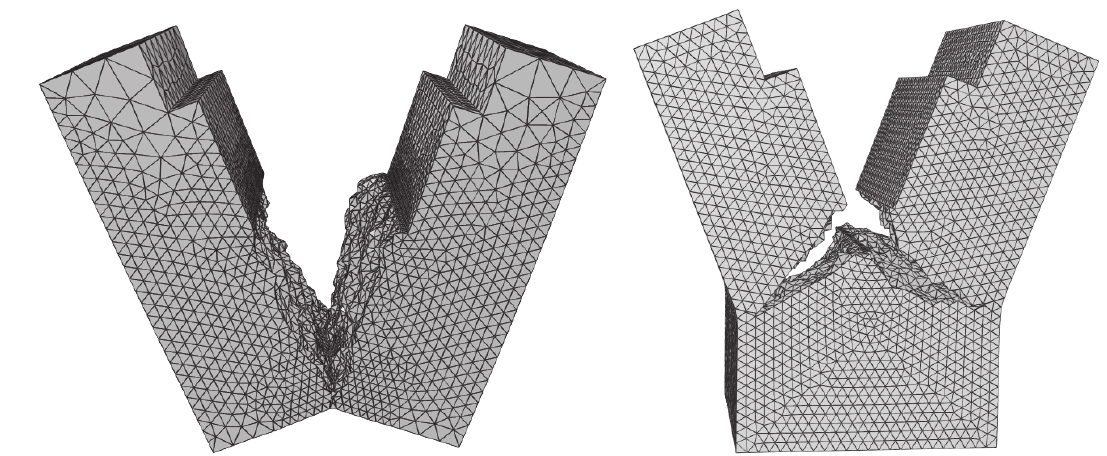
Figure 8: Possible failure modes of plain concrete (on the left) and fiber reinforced concrete (on the right).